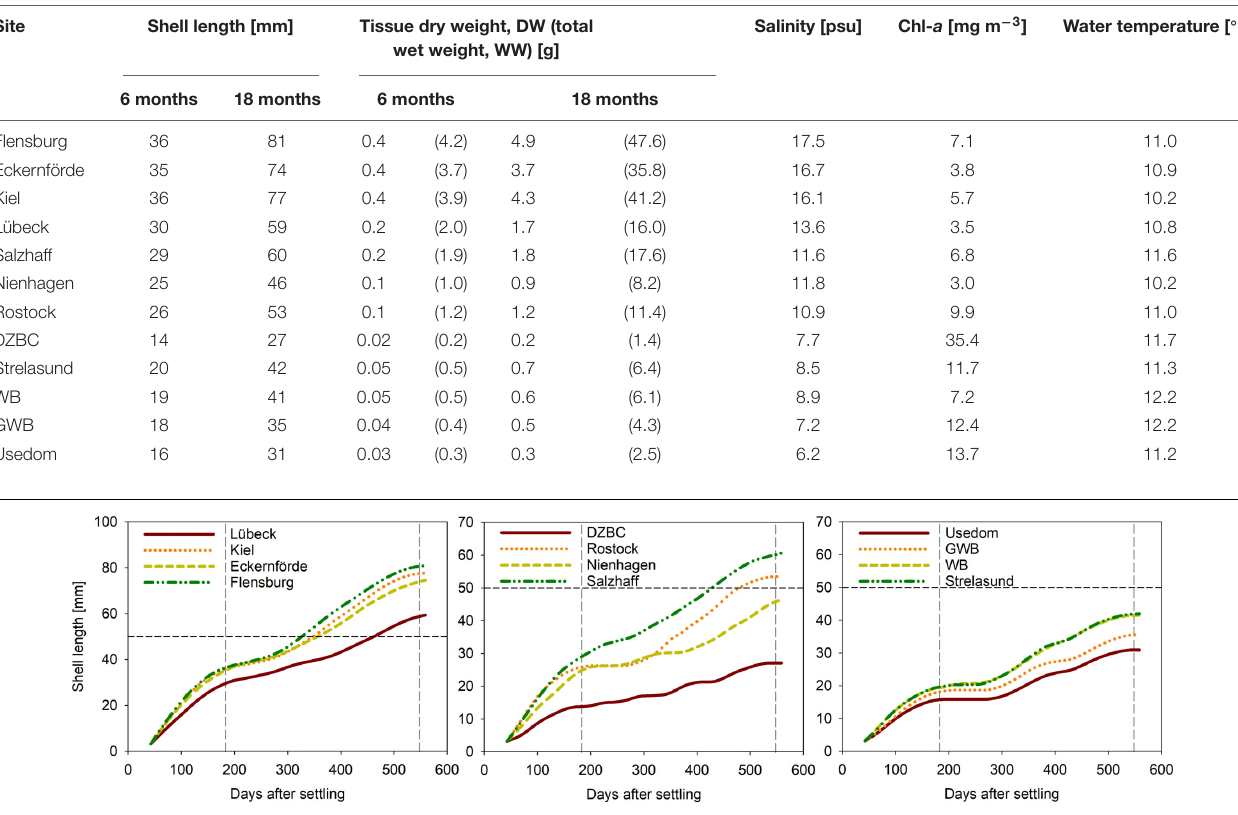
TABLE 4 | Modeled shell length and tissue dry weight (DW) as well as calculated total wet weight (WW) after 6 and 18 months.